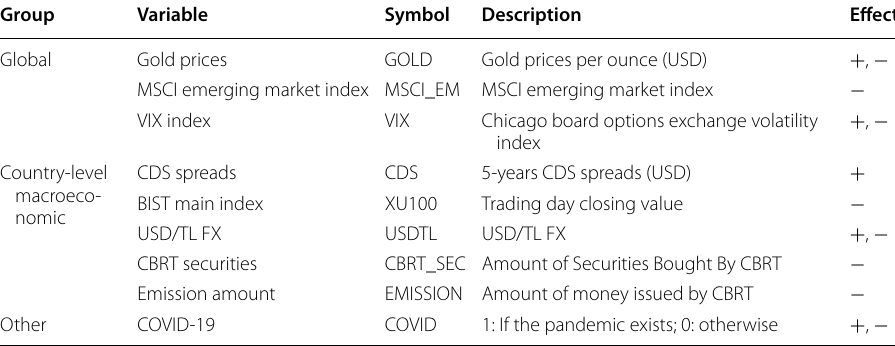
Table 1 Independent